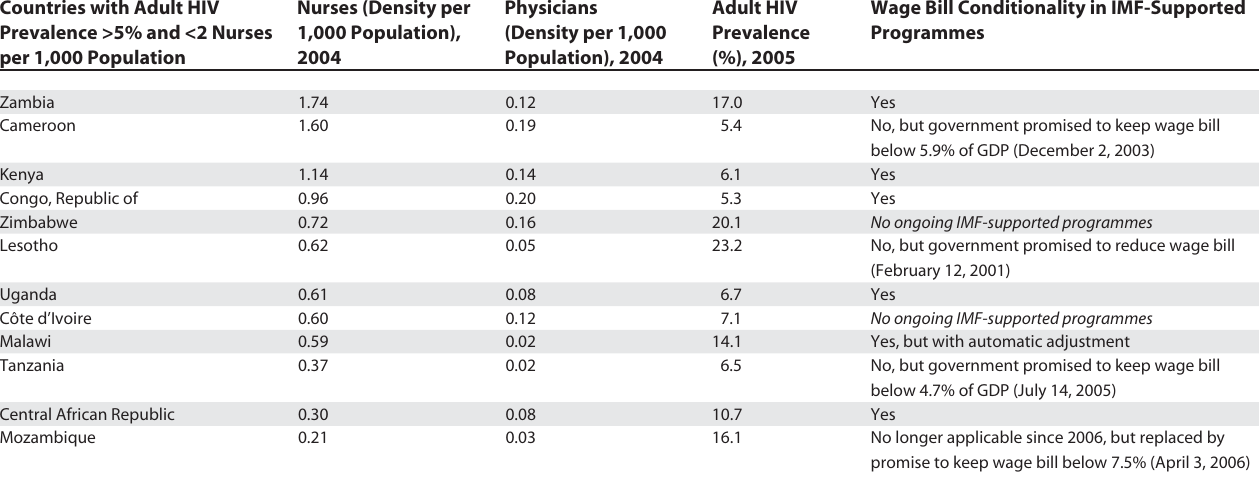
Table 1. Health Workforce Gaps and Wage Bill Agreements in 13 African Countries Countries with Adult HIV Nurses (Density per Prevalence >5% and <2 Nurses 1,000 per 1,000 Population